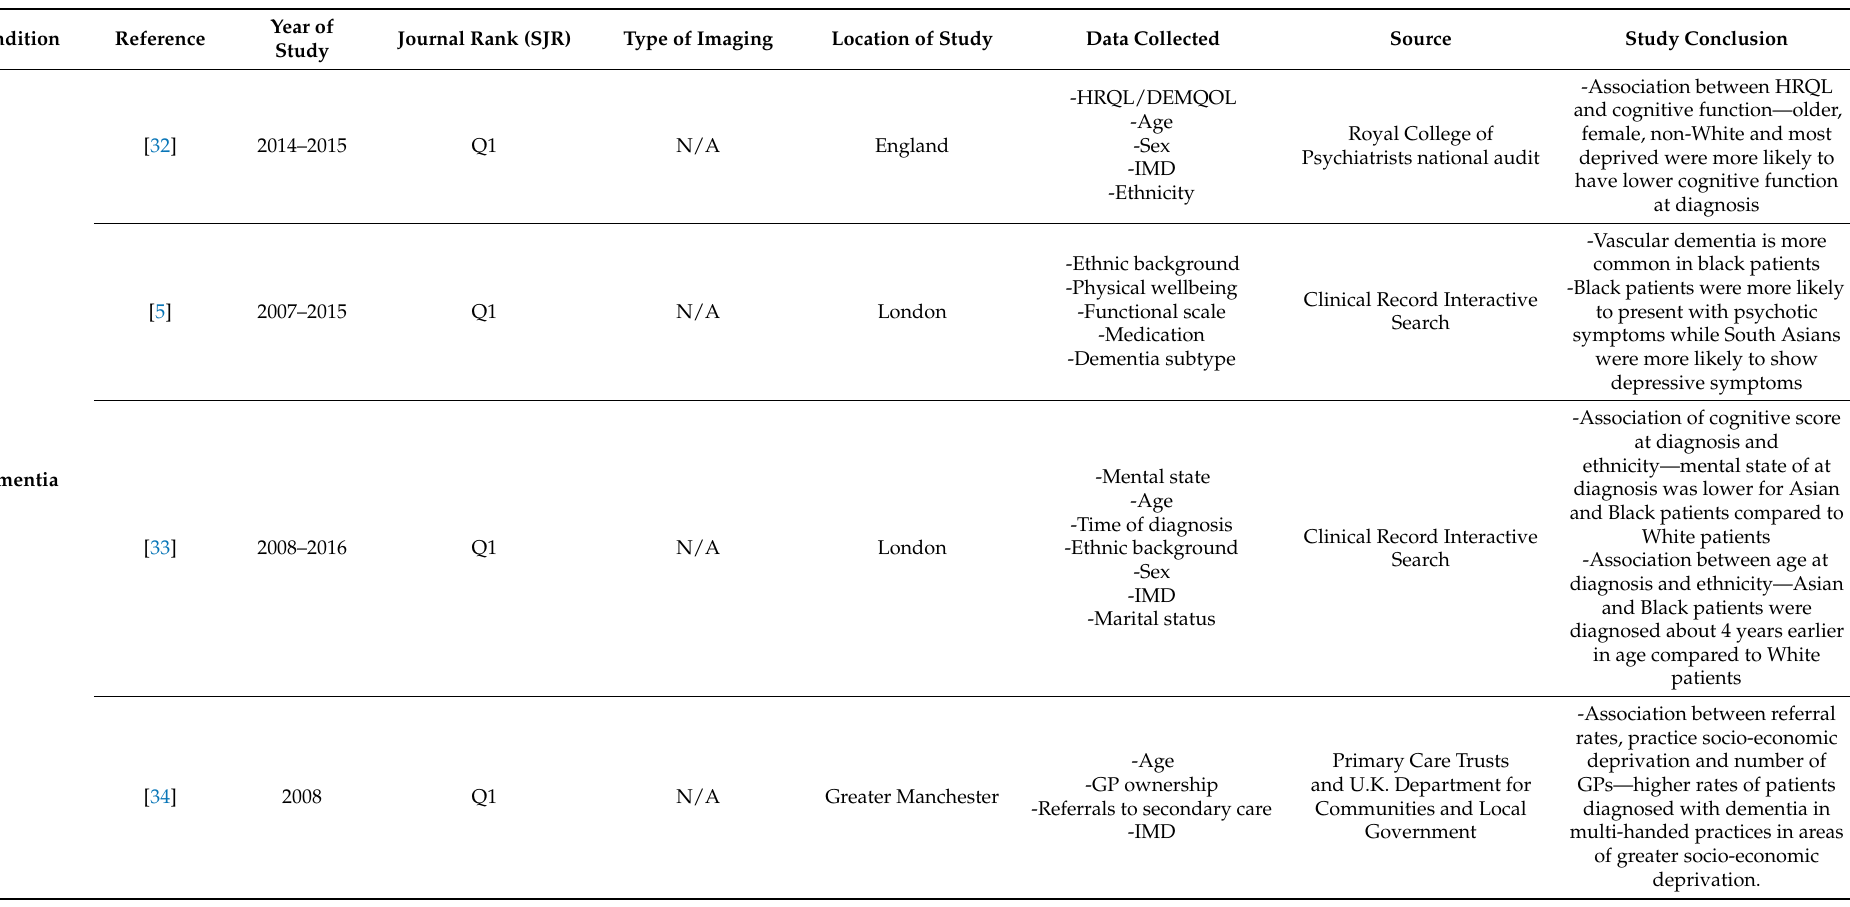
Table 5. Summary of